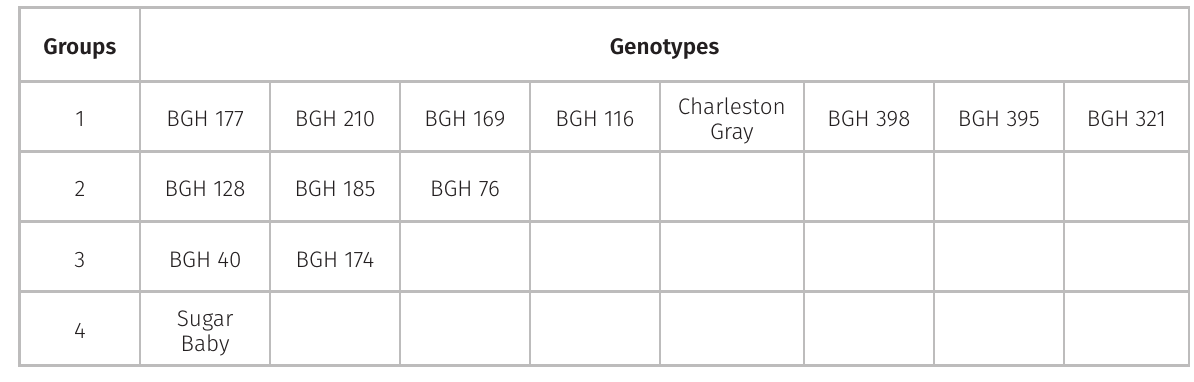
Table IV. Grouping obtained by the Tocher method based on the sum of the dissimilarities matrices obtained by the standardized Euclidean mean distance for the